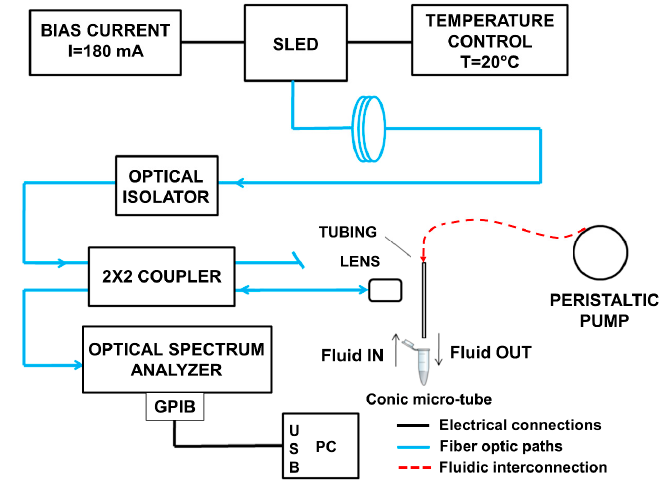
Figure 7. Block diagram of the setup applied in the experiments. The different kinds of connections (electrical, optical and fluidic) are highlighted. SLED: Superluminescent Light Emitting Diode.